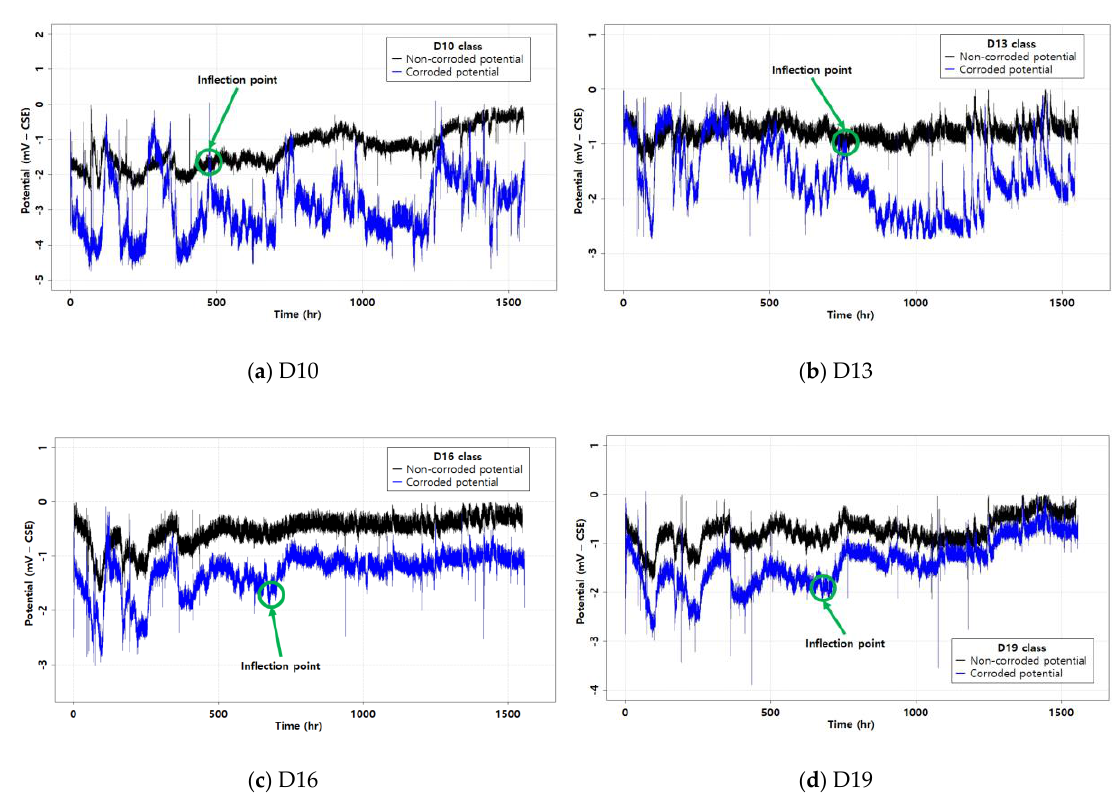
Figure 3. The corrosion potential results: ( a ) D10; ( b ) D13; ( c ) D16; ( d ) D19.